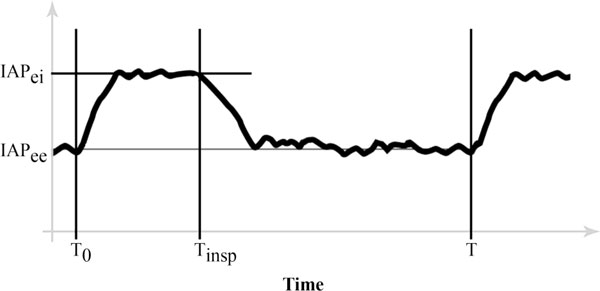
Effect of respiration on intra-abdominal pressure (IAP). T0, start of inspiration; Tinsp, inspiratory time; T, total respiration time; IAPee, end-expiratory IAP; IAPei, end-inspiratory IAP.